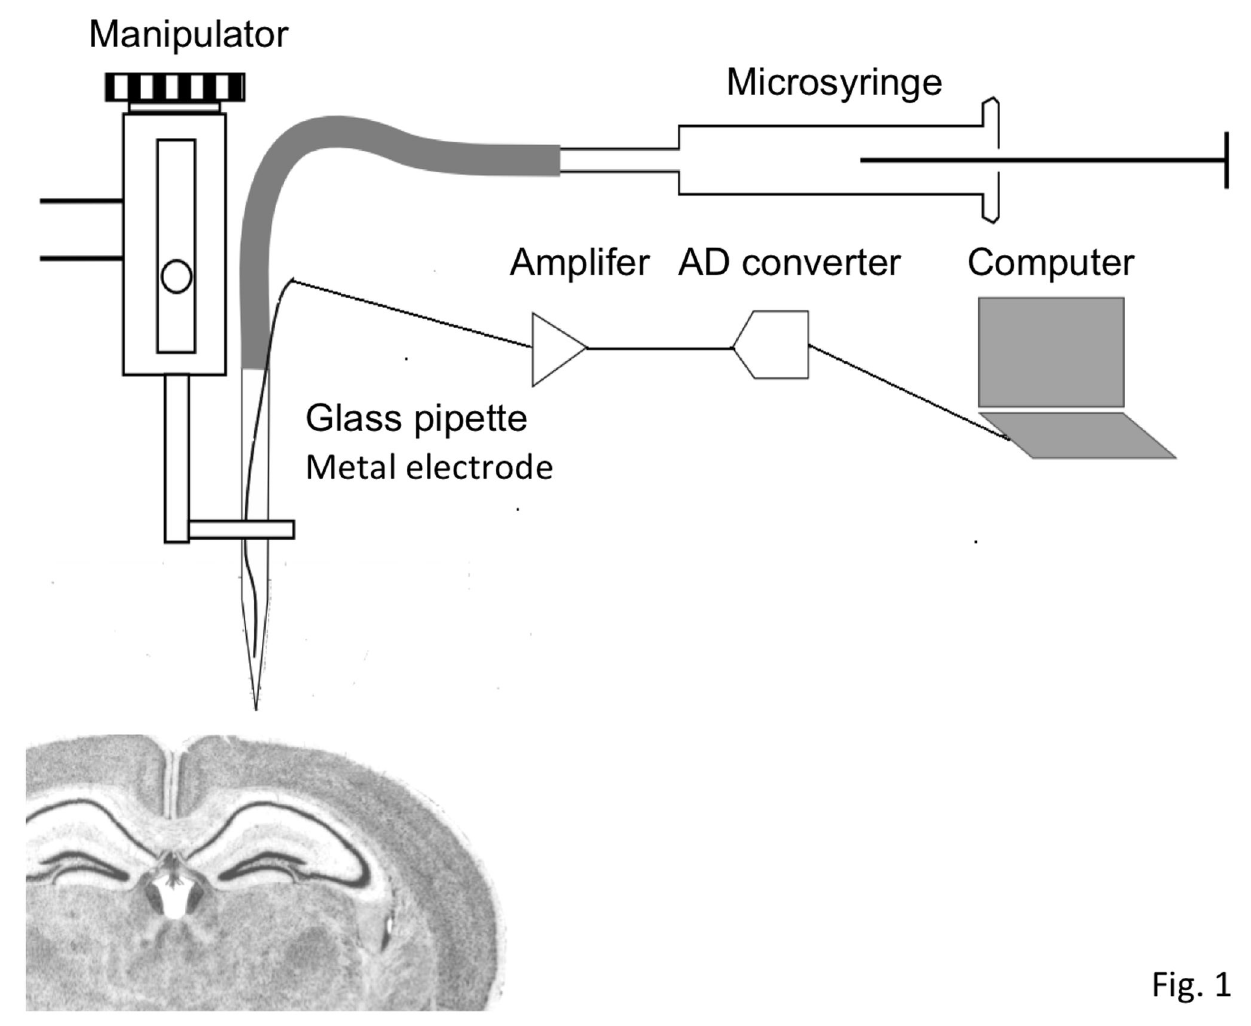
Figure 1. Schematic representation of the injection/recording system presented in the study. A glass pipette containing copper or Ag/AgCl EEG electrode is attached to a micro-syringe via a connection tube and is controlled by a manipulator. The electrode is connected to a personal computer to analyze the recorded signals and to calculate the real-time integrated value of the theta